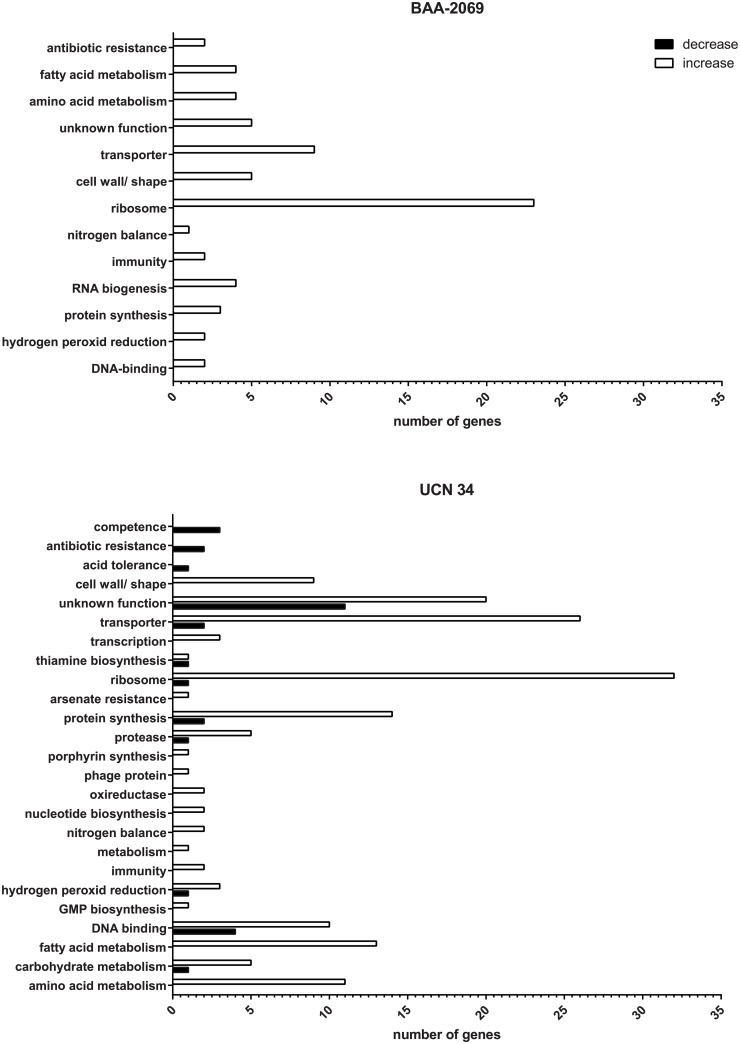
The number of regulated genes determined by microarray analysis.The number of genes which were regulated in the S. gallolyticus subsp. gallolyticus strains BAA-2069 and UCN 34 after lysozyme treatment for 5 h (black: decrease, white: increased) are displayed on the x-axis. Genes were sorted into functional categories.